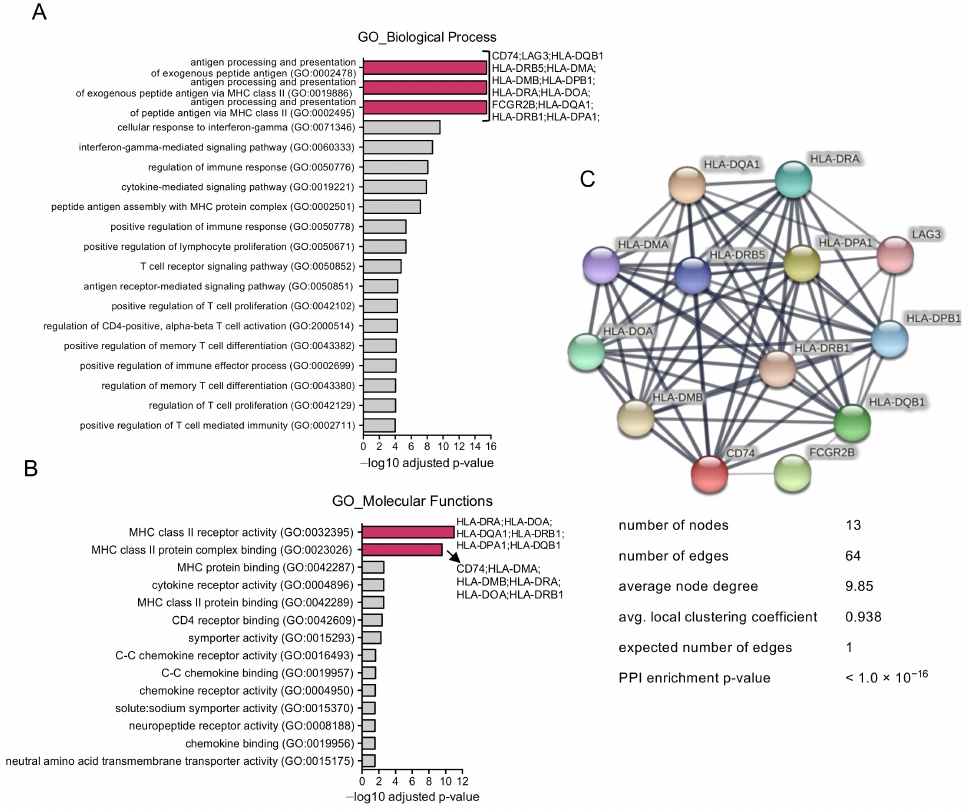
Figure 2. Upregulated genes participate in immunological functions. Bar graph showing the top GO biological process ( A ) or molecular functions ( B ) of the selected genes according to their adjusted p -value. ( C ). Protein–protein interaction map displaying the significant functional network integrated by the genes involved in the molecular functions and biological process in pink bars in ( A , B